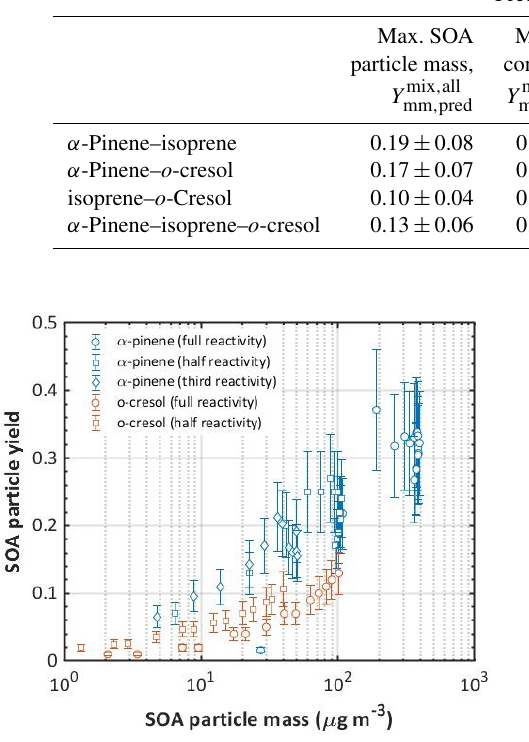
Table 4. SOA predicted yield for the four mixtures at maximum SOA particle mass produced and maximum VOC consumed. The uncertain- ties in SOA particle mass yield were calculated by propagating the ± 1 σ uncertainties of predicted SOA and measured VOC. Predicted yield at